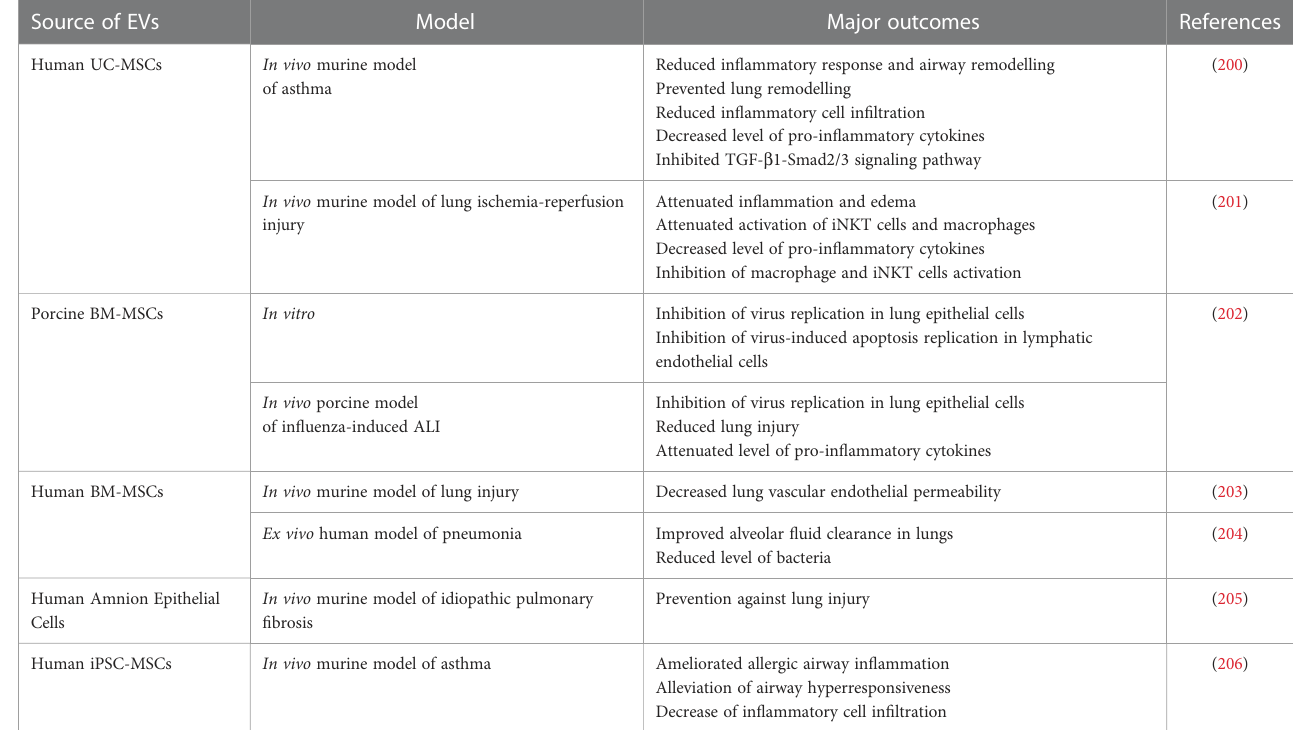
TABLE 5 Examples of EV use in preclinical studies related to the treatment of the respiratory system diseases. Source of